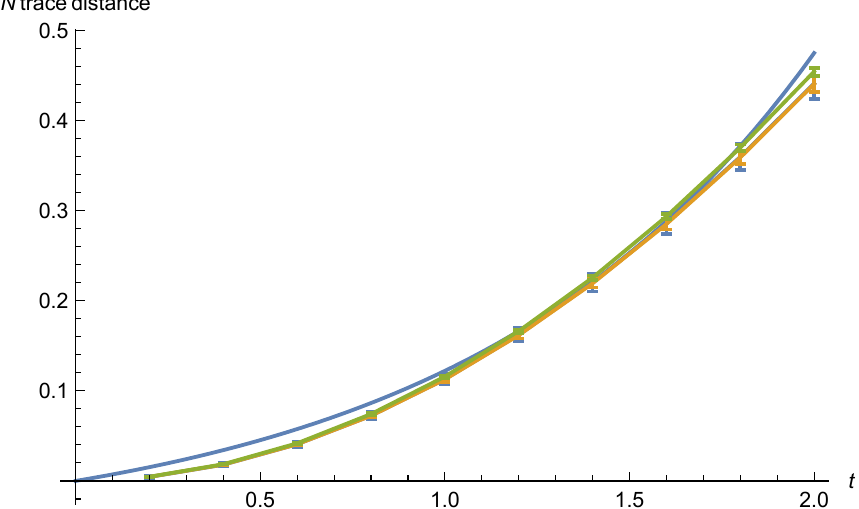
(cid:13) (cid:13) Figure 1 . N is plotted for various values of N (cid:20) 14. The error bars indicate (cid:13) (cid:26) lab ( t ) (cid:0) (cid:26) MF lab ( t ) (cid:13) 1 an uncertainty due to picking di(cid:11)erent initial states. The numerical data is bounded by the curve 0 : 065 (exp (1 : 06 t ) (cid:0) 1) shown in blue in the